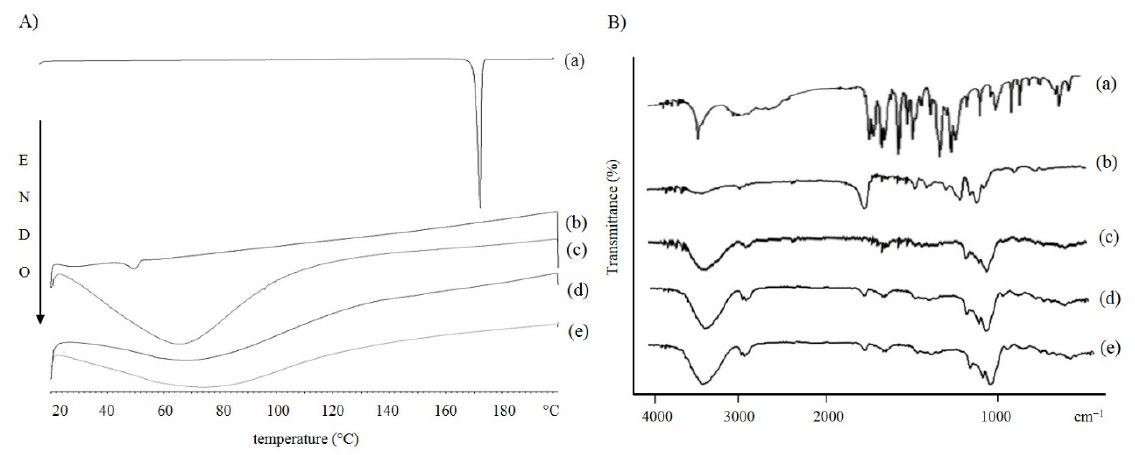
Figure 6. ( A ) DSC and ( B ) FT-IR curves of FA ( a ) PLA polymer ( b ) HP- β -CD ( c ) unloaded NPA ( d ) and FA-loaded NPA nanoparticles ( e ).